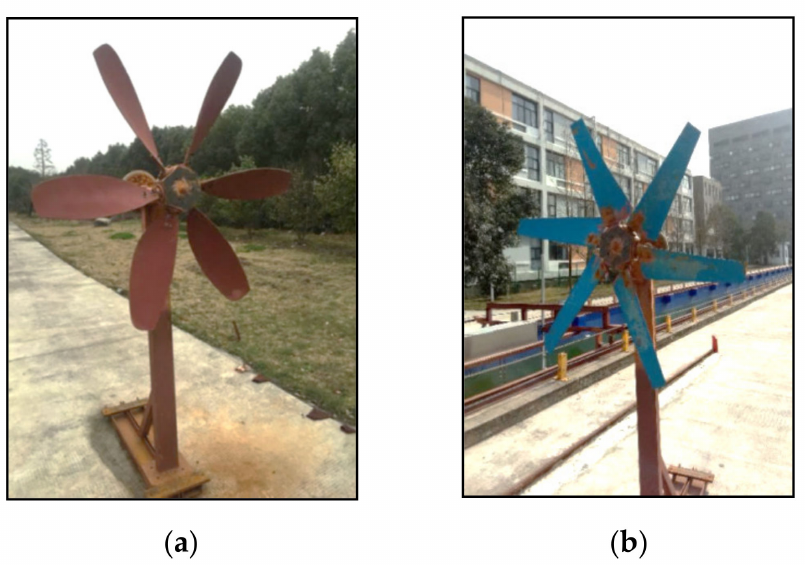
Figure 13. Physical image of the hydraulic turbine models: ( a ) thin-plate arc; ( b ) NACA airfoil.